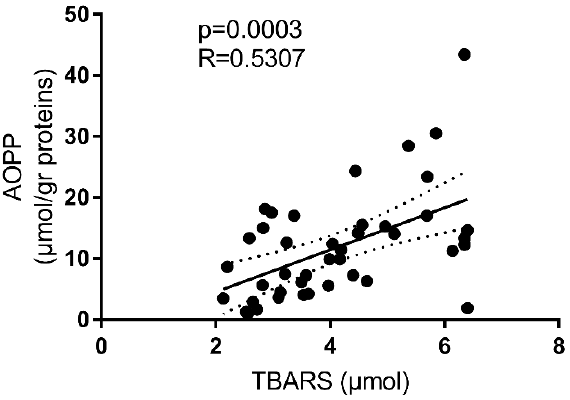
Figure 2. Correlation between AOPP and TBARS levels in the serum of Crohn’s patients.